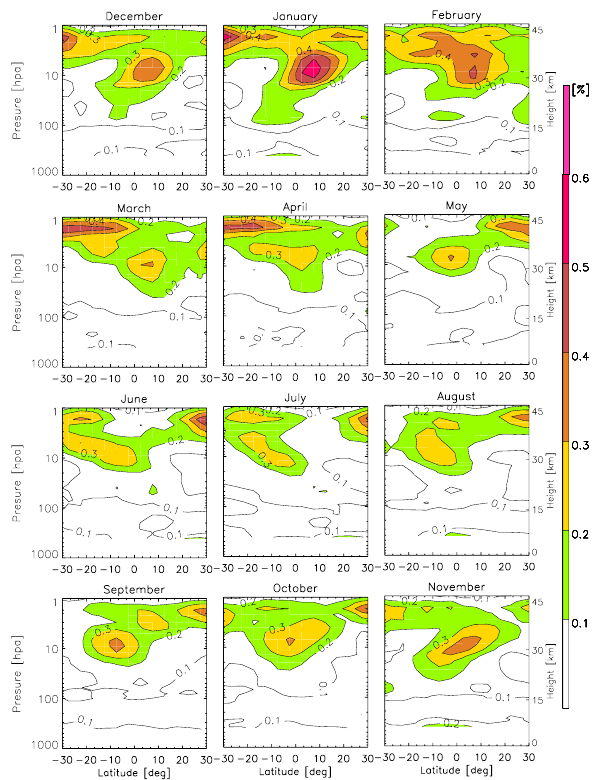
Fig. 4. Three-year averaged (2007–2009) vertical structure of zonal mean diurnal refractivity amplitude (in percentage) in twelve months. Only the pressure leves less than 400Pa (or above ∼ 7km) are